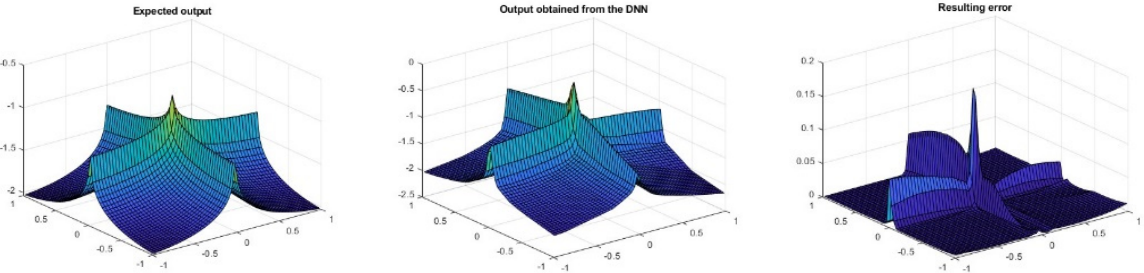
Figure 25. Expected output of the DNN for the Cross-in-Tray function on the left, the obtained results in the middle and the error on the right.